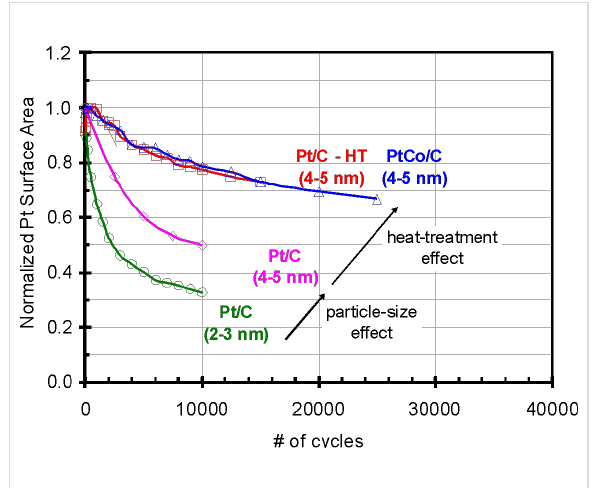
Figure 12: Impact of catalyst particle size and post-synthesis heat treatment on the normalized platinum surface area loss. The test was performed with H 2 on the anode and N 2 on the cathode at 80 °C, 100% RH. The cathode side of the membrane electrode assembly (MEA) is cycled between 0.6 and 1.0 V RHE at 0.02 V·s − 1 . The graph was reproduced from [81] with permission. Copyright 2006 The Elec- trochemical